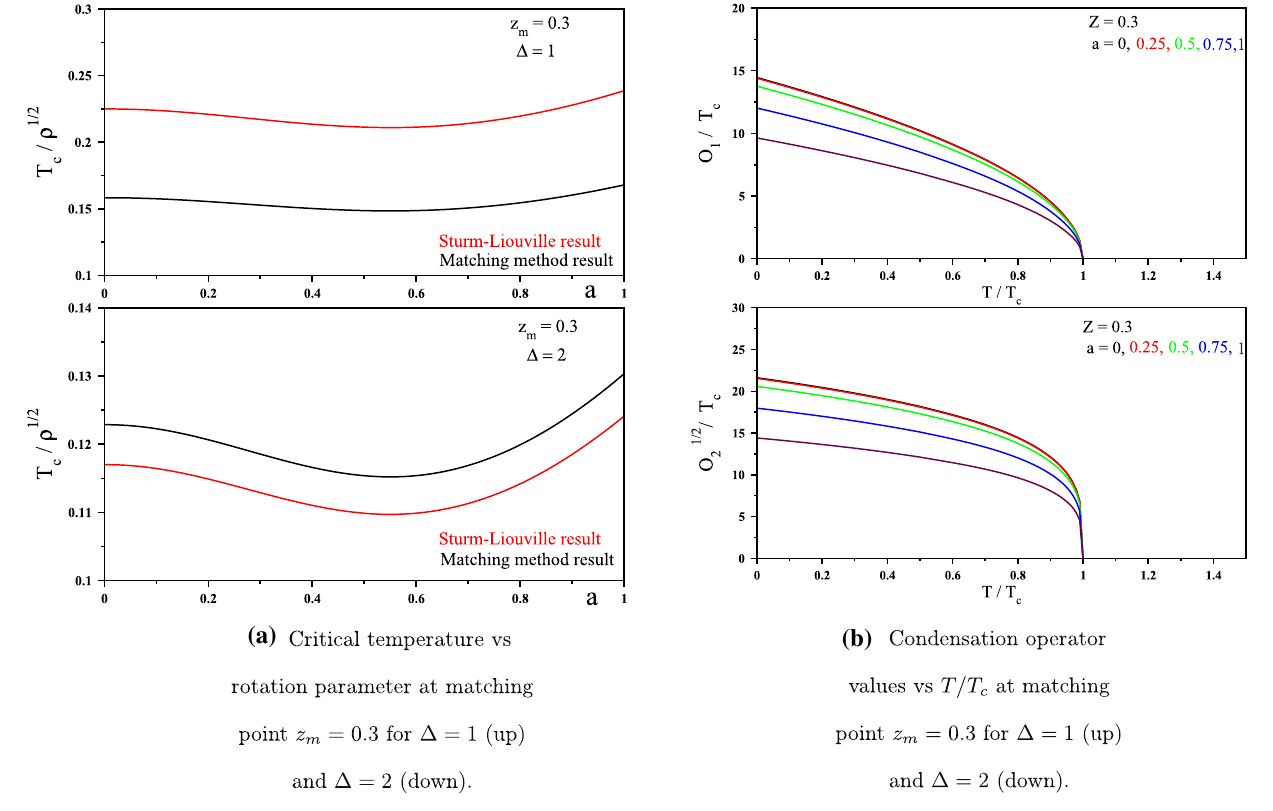
Fig. 1 Analytical results using matching method and Stürm–Liouville analysis Table 1 Critical temperature at different matching points for (cid:19) = 1 ,